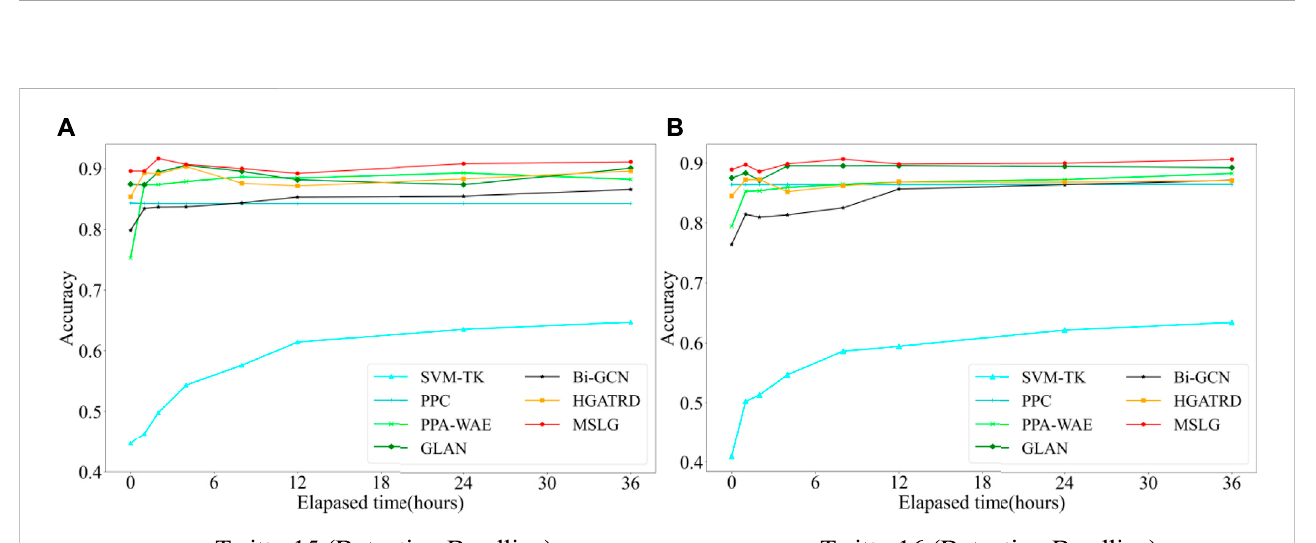
FIGURE 3 The performance of models with different parameters on two datasets.